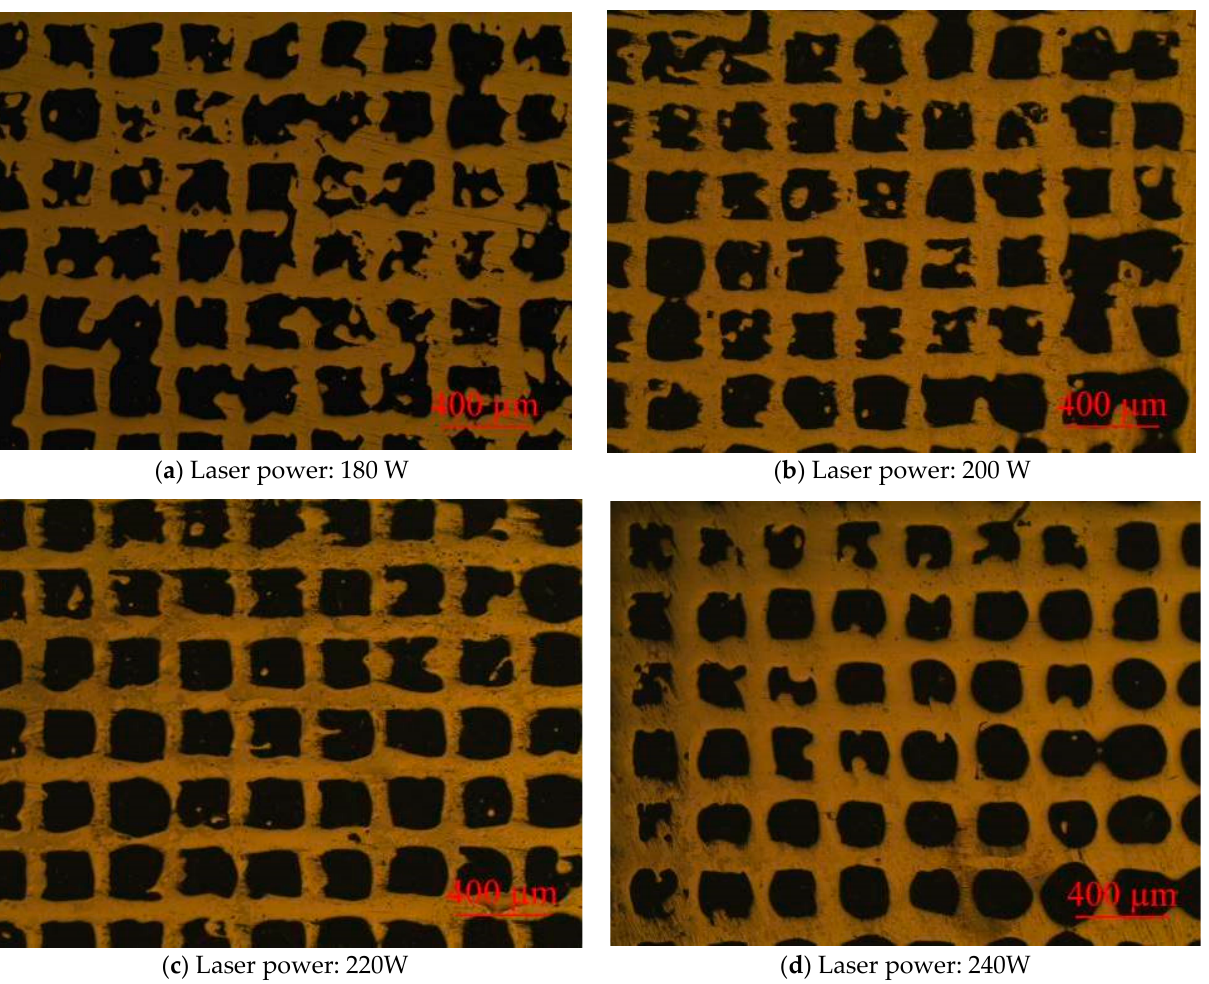
Figure 6. Images of the polished grid structures formed with a 0.3 mm scan spacing and different laser power values.